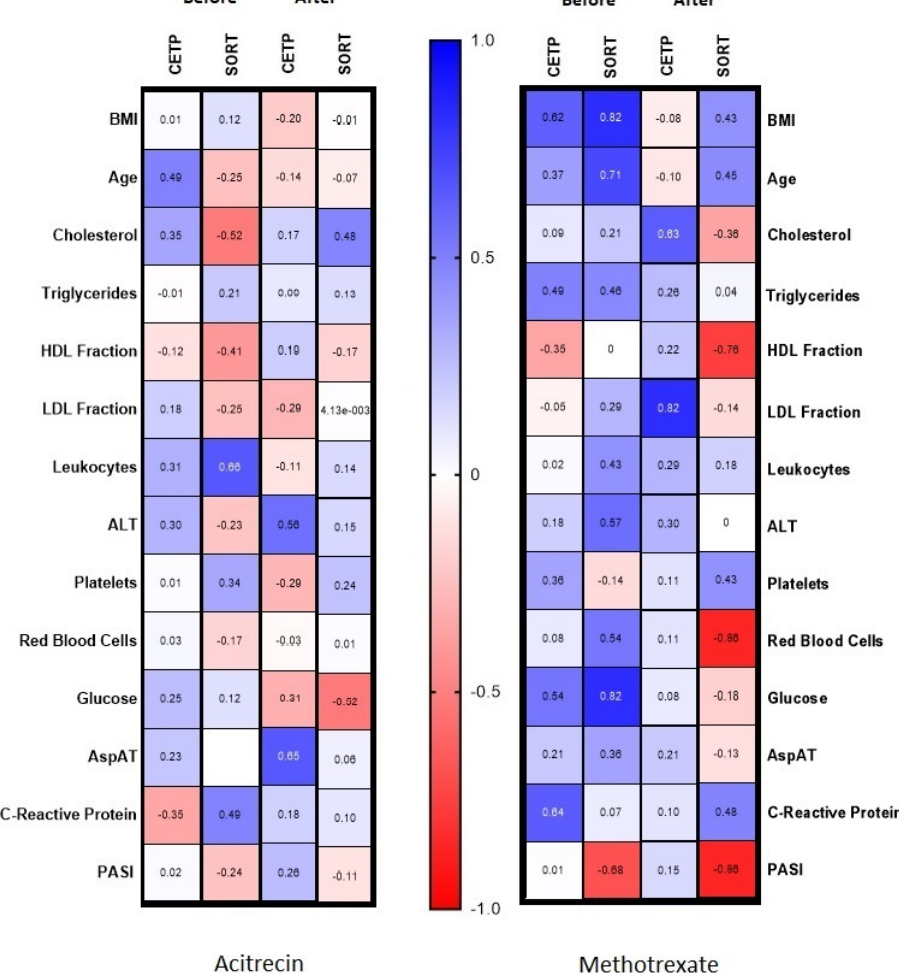
Figure 4. Correlations of SORT and CETP in acitretin and methotrexate groups with the basal parameters before and after treatment.